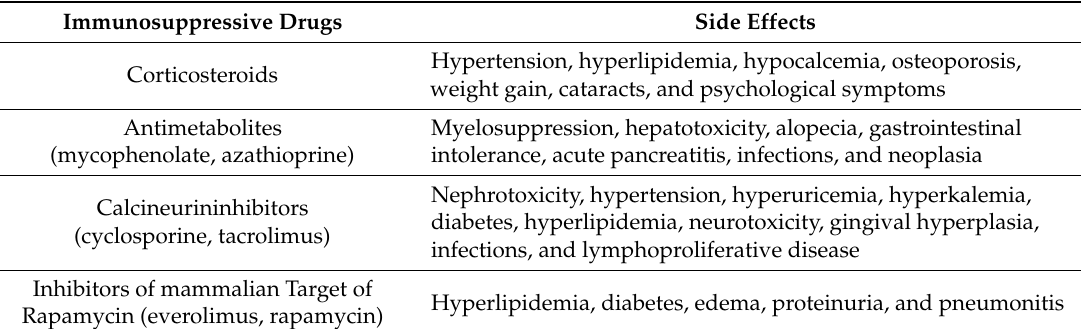
Table 4. Main side effects of immunosuppressive